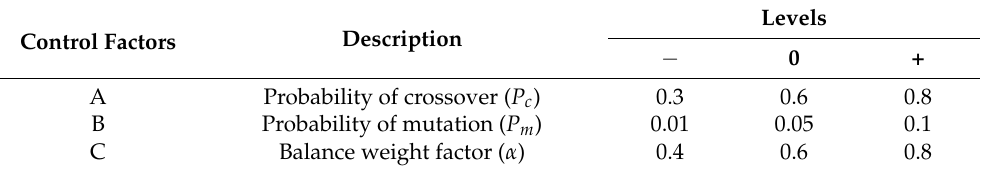
Table 1. Input signal factors and levels.